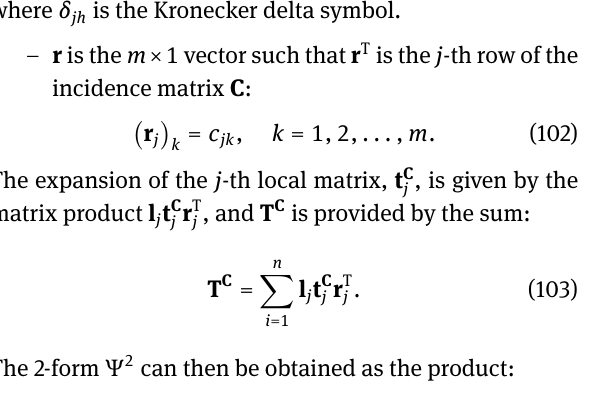
dimensions of the 1 × 1 matrix t C element is 1/ S j